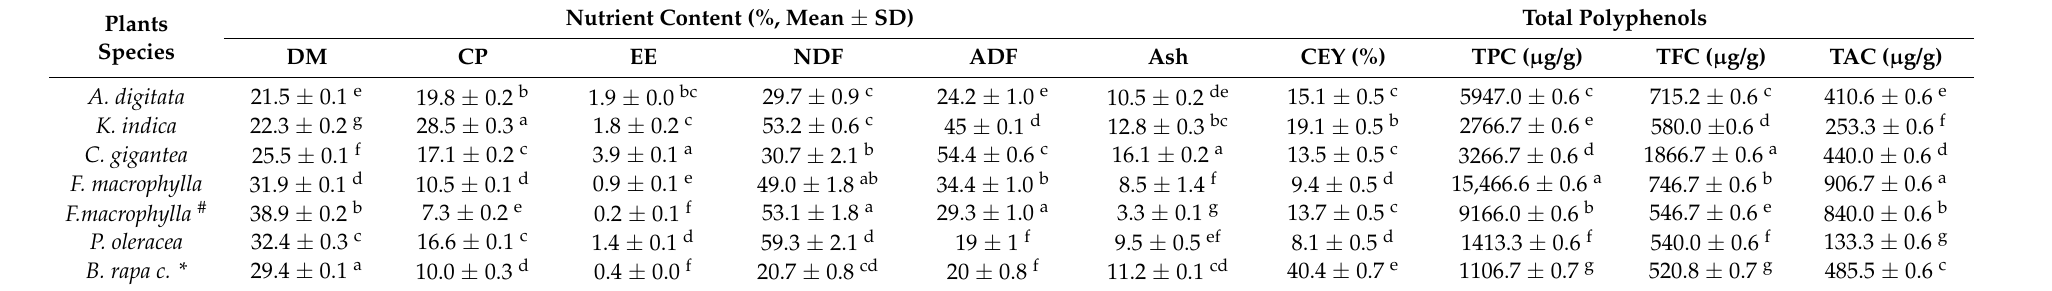
Table 1. Nutritional evaluation and total polyphenol composition of the tested plants.